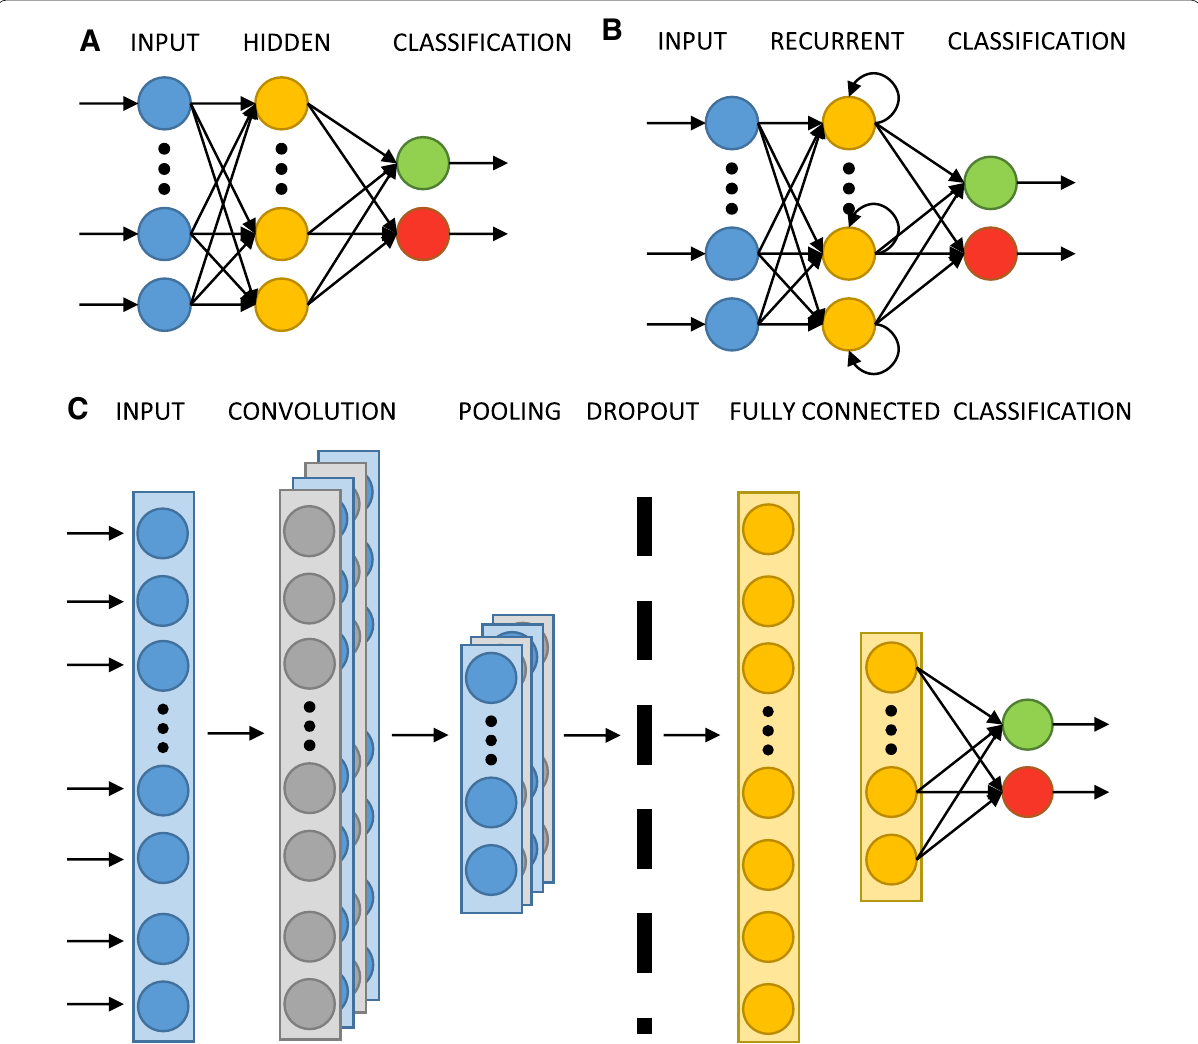
Fig. 3 Architectures of different neural network models: multi-layer perceptron ( A ), long short-term memory ( B ), and one-dimension convolutional neural network ( C ). Each circle represents a neuron, multiple rectangles a layer’s depth, and the arrows how the information is propagated throughout each network